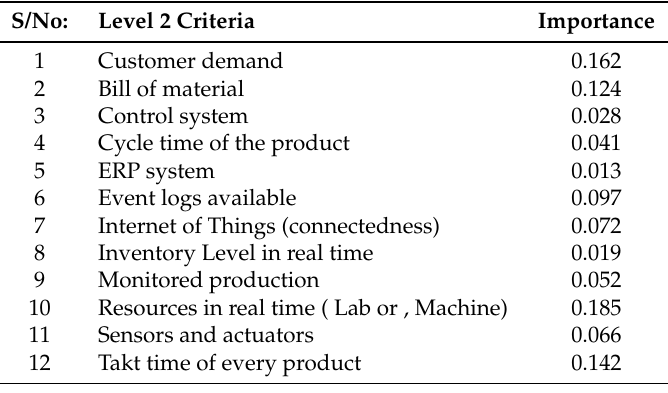
Table 4. Level 2—subcriteria 1.